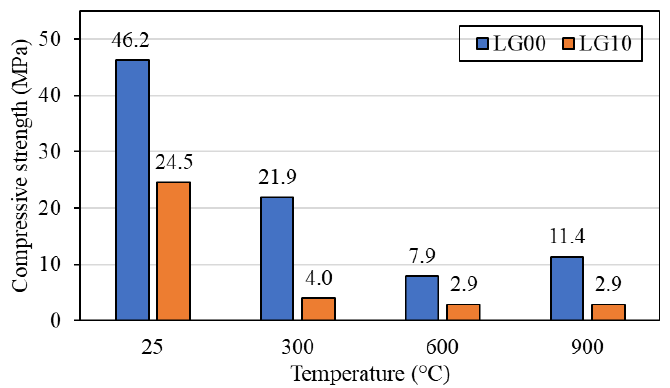
Figure 17. Compressive strength of LG00 and LG10 after exposure to elevated temperatures.